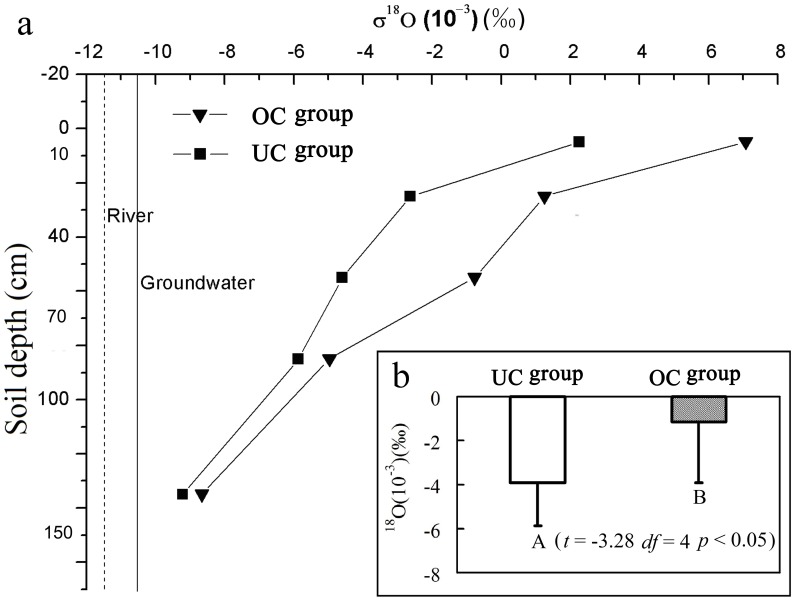
Difference in δ18O value with soil depth between UC and OC groups.UC is the community under the P. euphratica canopy, whereas the OC is the community outside the P. euphratica canopy. The soils were divided into five layers (0 to 10 cm, 10 to 40 cm, 40 to 70 cm, 70 to 100 cm, and 100 to 150 cm) based on P. euphratica roots and underground water level distributions. Each point in the Fig. 1a showing δ18O for each soil layer sample, which was measured for three times continuously with the third result as the experimental oxygen isotope value. Nine soil samples for each soil layer from three points were mixed to get one composite soil in each group. 18O contents of river (−11.55‰) and underground water (−10.59‰) are show through vertical dashed and solid lines respectively in Fig. 1a. Fig. 1b shows the mean comparison between UC and OC groups and the data in parenthesis showing the Paired-Sample t-test result. (Mean ± SD) for significance difference between two groups.